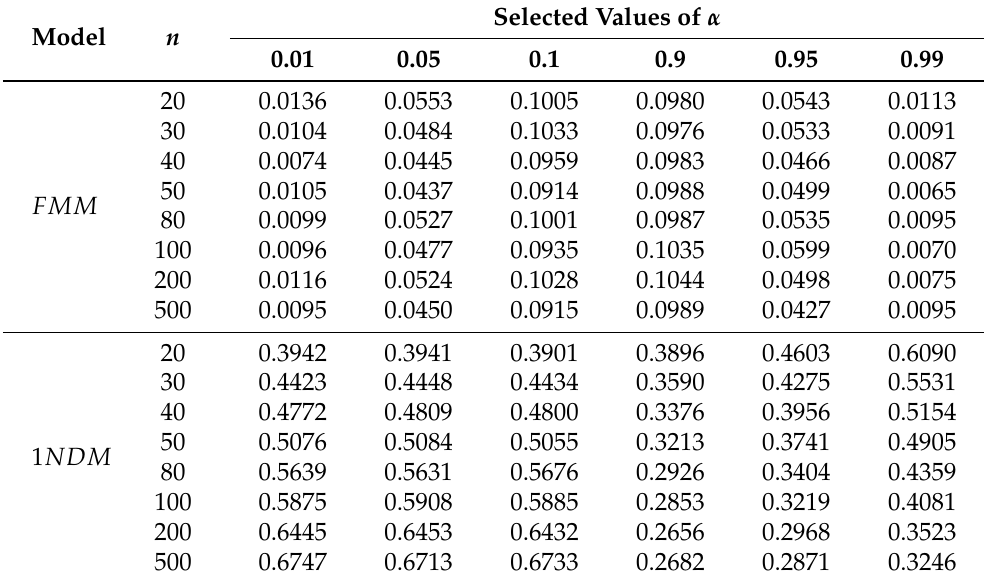
Table 10. EMAS test: proportion of times where the null hypothesis is rejected (variance case) when using the FMM and the 1NDM (based on 5000